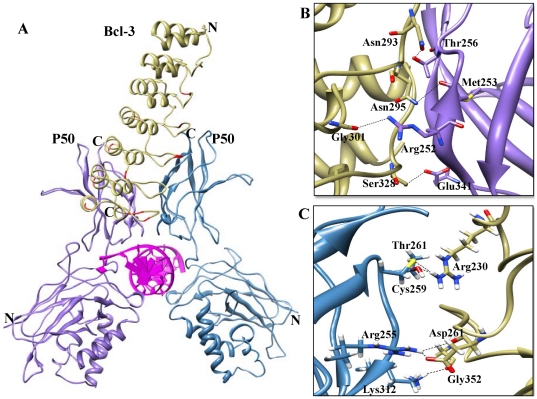
Complex A (Bcl-3 ARD-p50/p50 homodimer) interface.(A) The p50/p50 homodimers represented as a ribbon diagram are shown in purple and blue, respectively. Docked Bcl-3 is represented in khaki color in the ribbon diagram, and flexible residues involved in the interactions are red colored. (B) The p50 (chain A)-Bcl-3 binding interface. Side chains of the amino acids contributing to hydrogen bonding formation (indicated by black dotted lines) are represented by a stick model with the residue names and numbers shown next to them. (C) The p50 (chain B)-Bcl-3 binding interface is also represented in a similar fashion as (B).